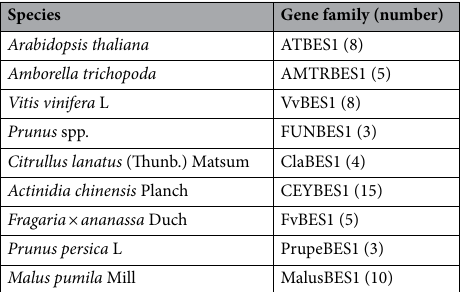
Table 2. Identified members of the BES1 protein family in diverse plants. A total of nine species were discussed in this study, including V. vinifera , A. thaliana , A. trichopoda , A. chinensis , F. ananassa , C. lanatus , M. pumila , P. persica , and